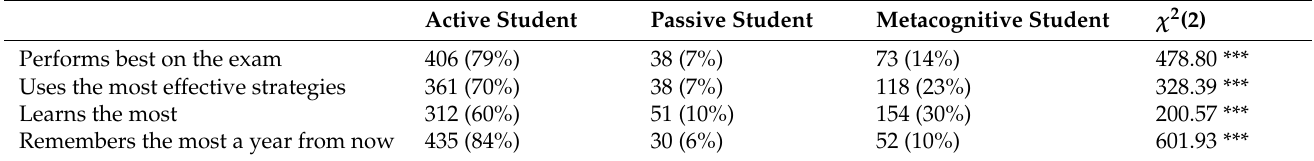
Table 6. Categorical Responses to Which Student Would Learn and Perform the Best in Study 2.